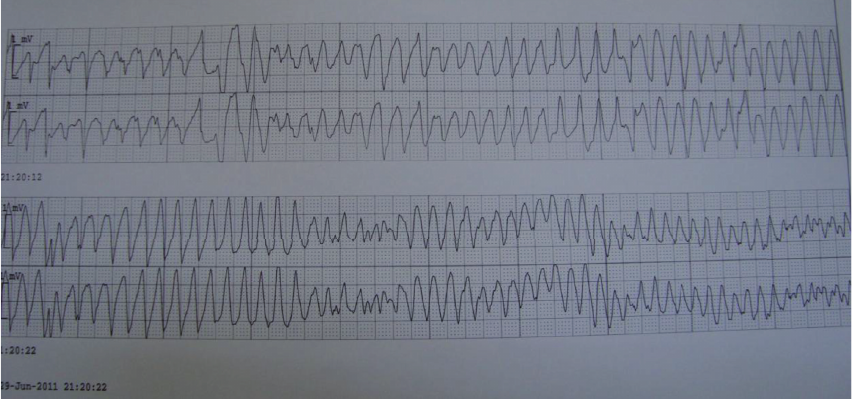
Figure 2: Bedside monitor showed TdP. TdP: torsade de